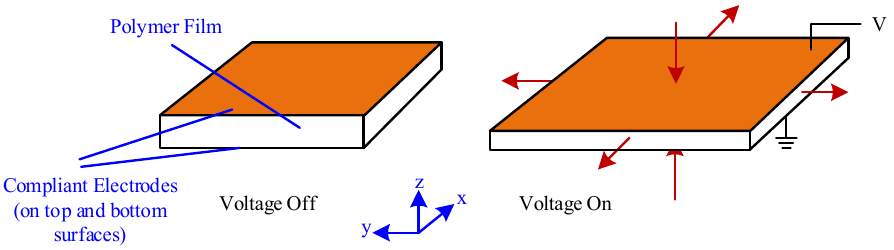
Figure 9. Working principle of DEA.